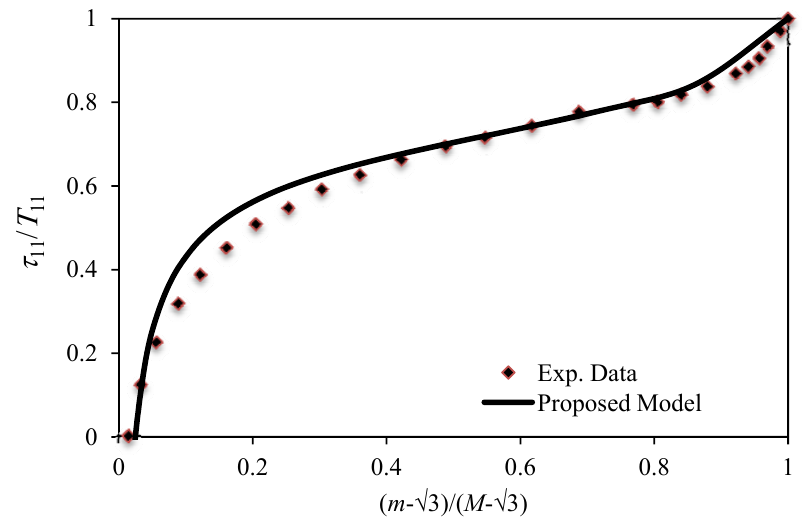
Figure 7. Comparison of theoretical predictions with respect to experimental data for 1 phr NR-MWCNT. Experimental data adapted from [30].